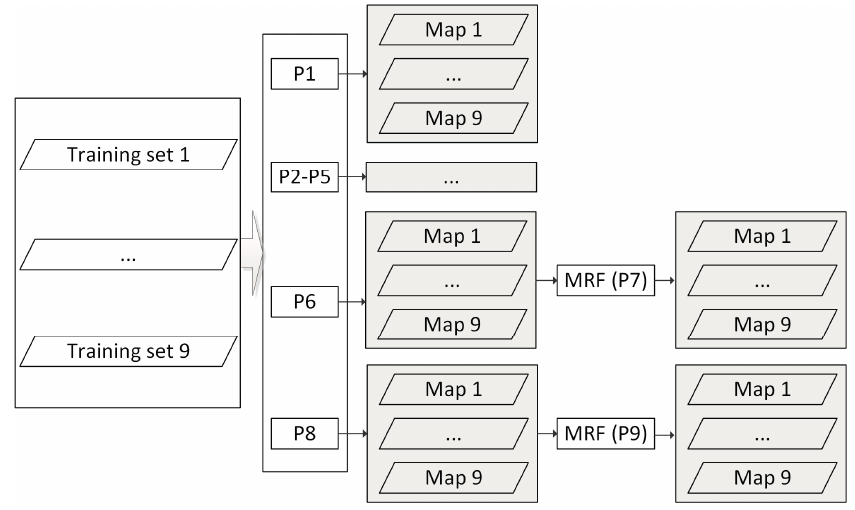
Figure 3. Dynamic land-cover classification